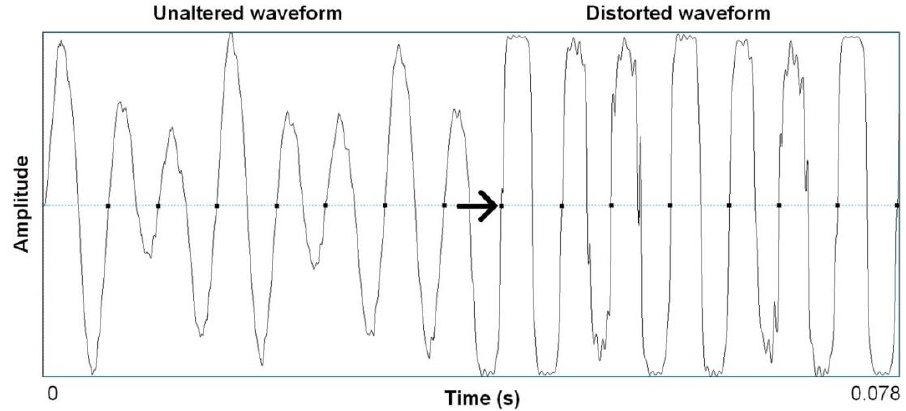
Figure 3. Waveform segments from the recording in Figure 2 of seven cycles (78 ms) of unaltered acoustic guitar and the same seven cycles after wave shaping functions (Camel Crusher VST Plug-in). Reproduced without modification from Bryant, 2013. (Creative Commons Attribution Licence).